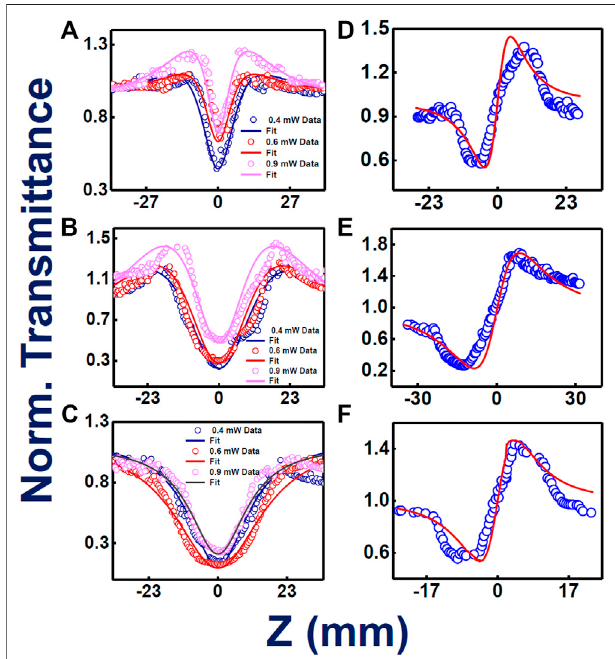
FIGURE 5 | Femtosecond kHz pulses involved experimental and theoretically fi tted Z-scan data (intensity dependent) open aperture (A – C) and closed aperture con fi gurations (D – F) for TMPc , Zn-TMPc, Cu-TMPc , respectively, in solution form. Open symbols are the experimental data while the solid lines represent theoretical fi ts.